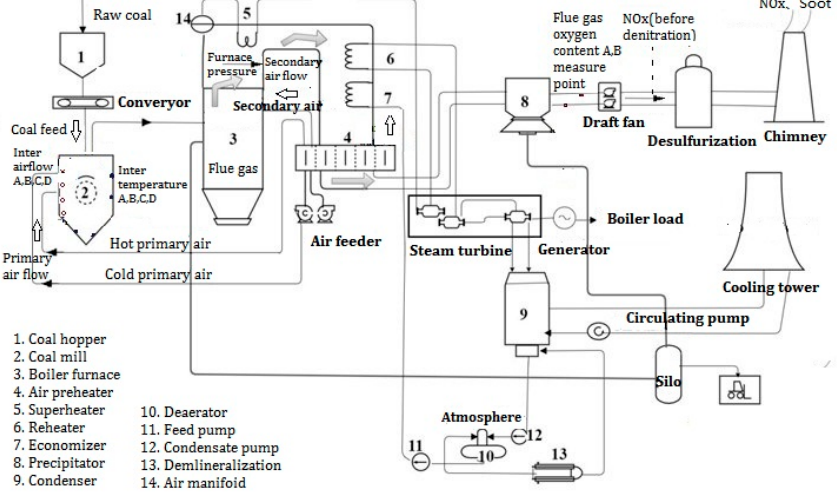
Figure 1. The description of coal-fired boiler production process.